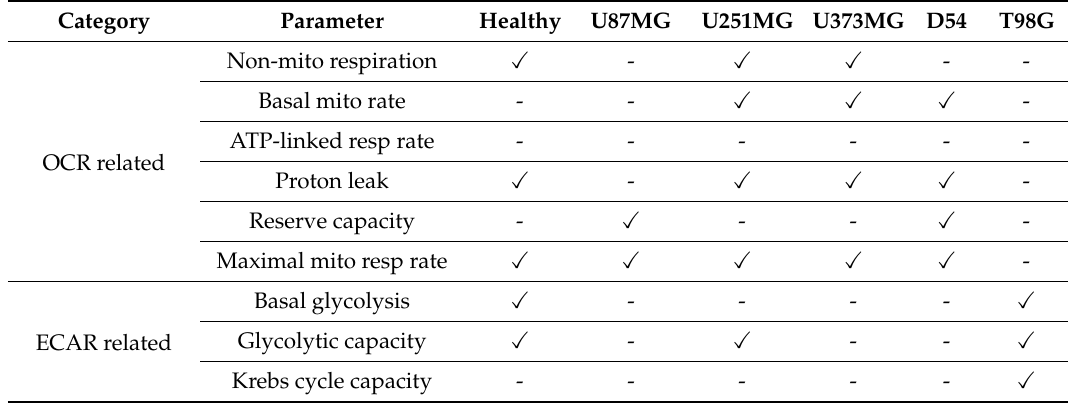
Table 3. Which cells reflect the metabolic activity of primary GBM